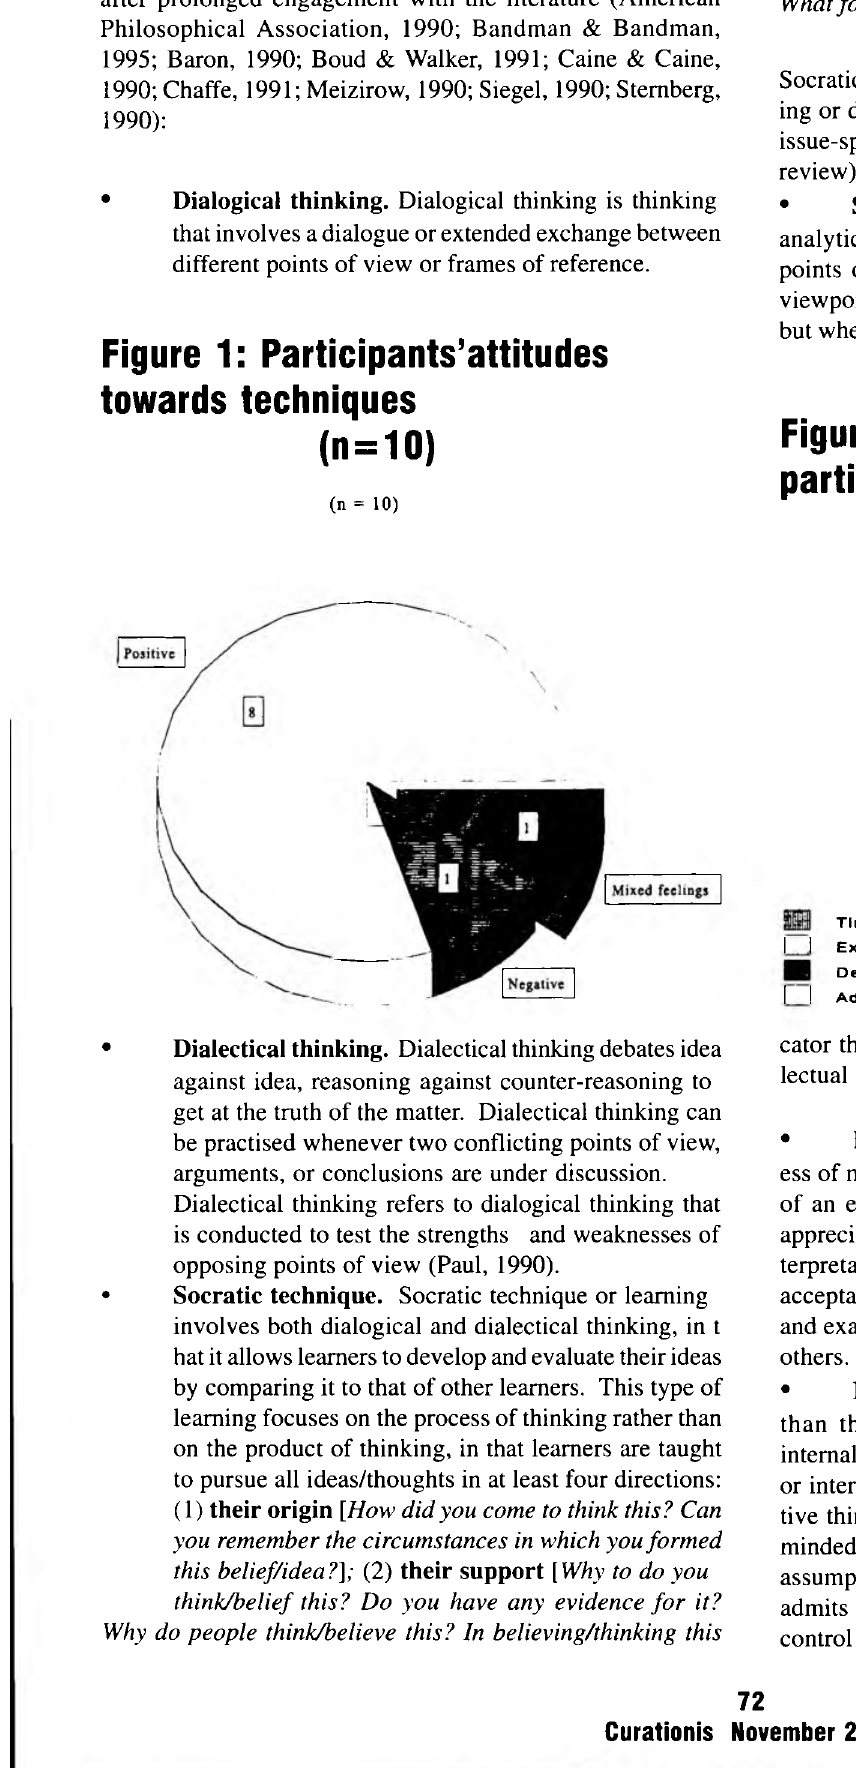
Figure 2: Problems experienced by participants (n = 10